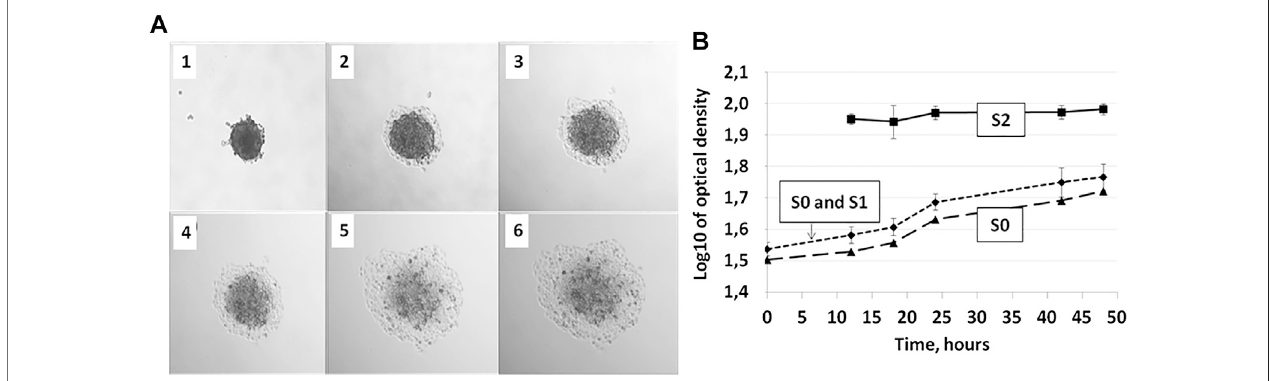
FIGURE6| ZonesS0,S1,andS2during36 hofincubationoftheMCTSonplasticaredistinguishablebyopticaldensityallowingforautomatedimageanalysis. (A) MCTSonplastic immediately after planting (1),after 12 h (2), 18 h(3), 24 h(4),28 h (5),and 48 h (6)ofculturing (B) Changesin therelative values ofgray colorinS0, S0, and S1 and S2 zones of the cell inhabited area. Data obtained from eight technical repeats and presented as the mean ± SD. For corresponding values see Supplementary Tables S1, 2, 4 .